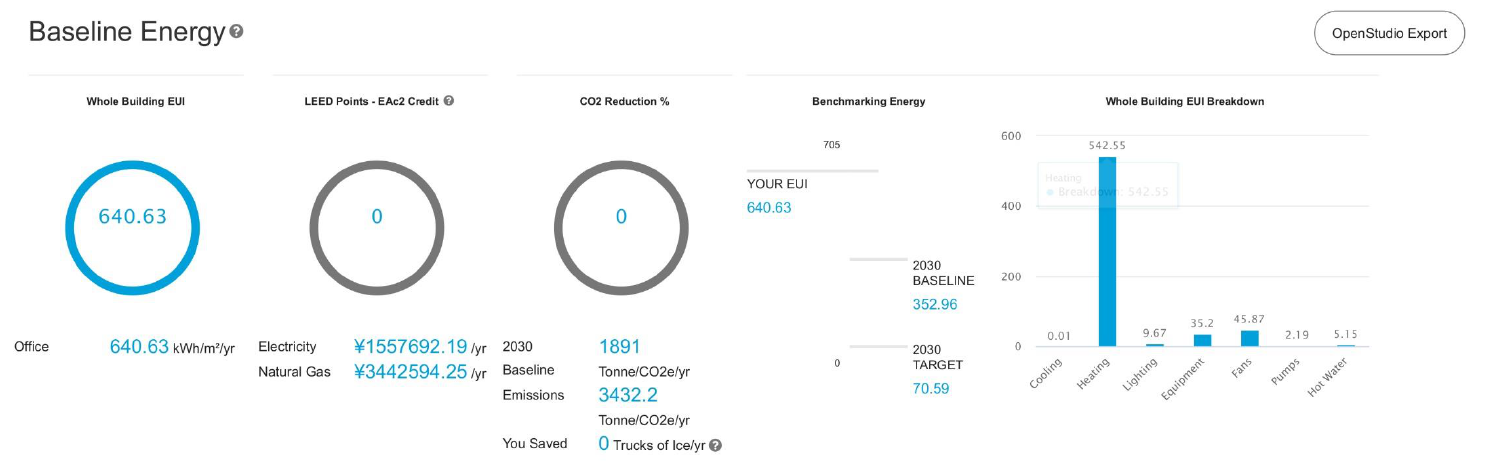
Figure A44. Zone 7-H Delinghá, Qinghai (post-COVID-19 78% scenario).